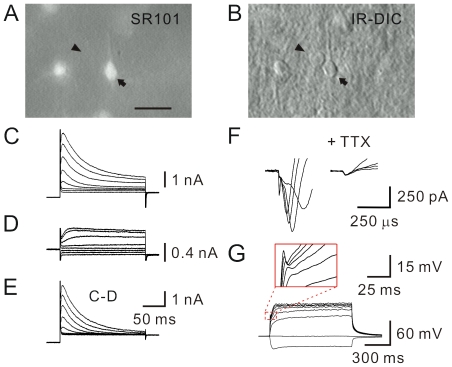
Identification of NG2-expressing cells in the hippocampus.(A) Epifluorescence image showing an SR101(+) cell (arrow) in the stratum radiatum of the CA1 area. Arrowhead, an SR101(−) cell, a putative NG2 cell, which was visible under IR-DIC optics in (B). Scale bar, 10 µm. (B) IR-DIC image of (A). (C) Total outward K+ currents recorded from an NG2 cell evoked by step voltages (20 mV, 200 ms) from −80 mV to +40 mV with an 1-s prepulse (−120 mV). (D) Delayed-rectifier K+ currents evoked in the same cell by the same step voltage protocol in (C) with an 1-s prepulse (−30 mV). (E) A-type K+ currents obtained by subtracting (D) from (C). (F) Left, representative inward Na+ currents evoked by step voltages (20 mV, 200 ms) from −10 mV to +50 mV with an 1-s prepulse (−120 mV). Right, after addition of TTX (0.5 µM). (G) Voltage responses to the current injection (−100 pA to +600 pA; step, 100 pA).